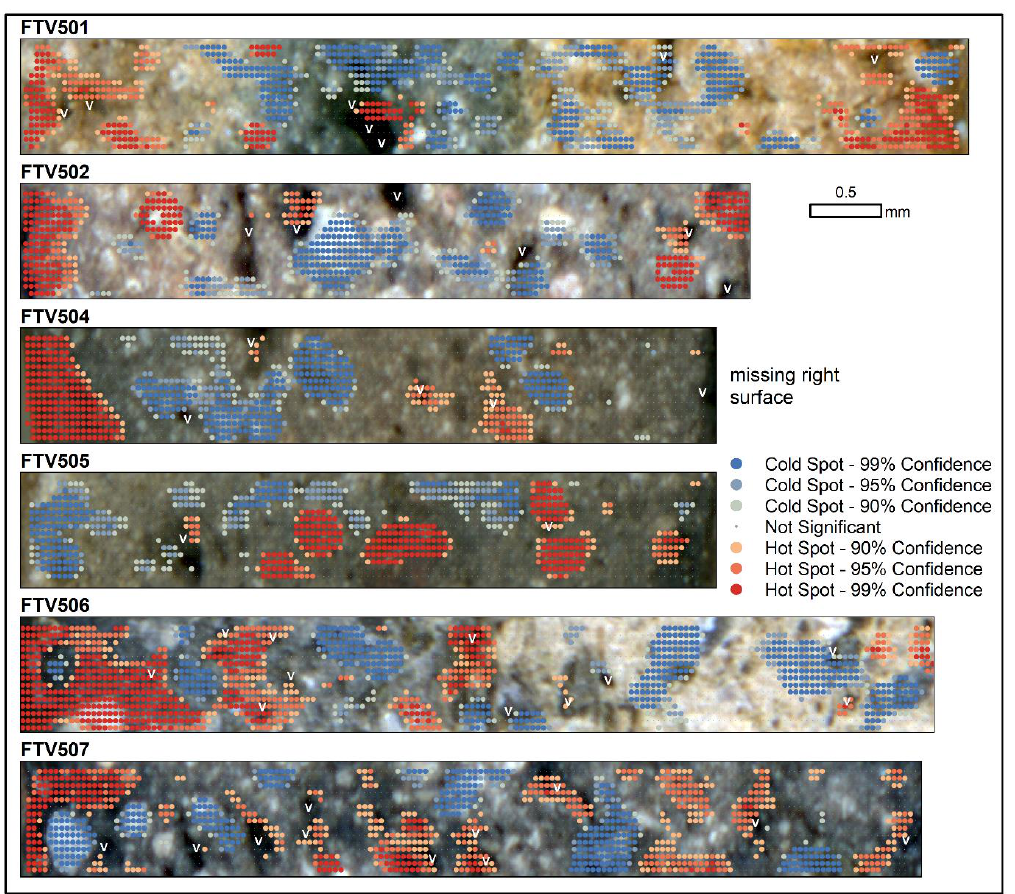
Figure 12. Results of Getis Ord Gi* for Group A3 showing hot and cool spots across the samples. “V” marks macroscopically visible voids.